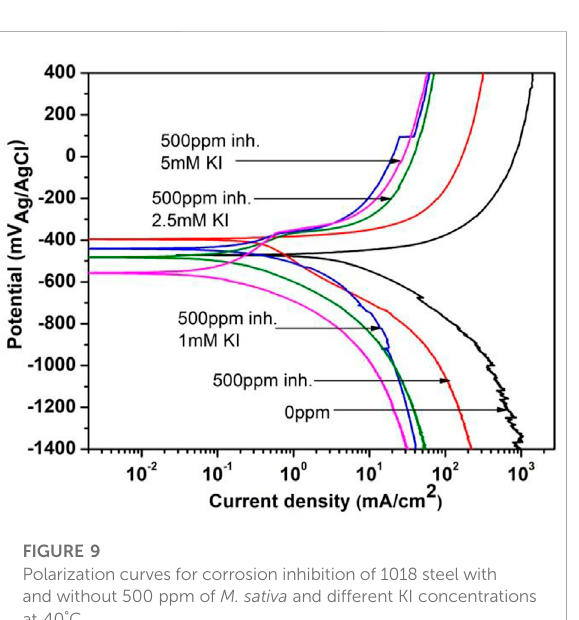
FIGURE 10 Polarization curves for corrosion inhibition of 1018 steel with and without 500 ppm of M. sativa and different KI concentrations at 60 °